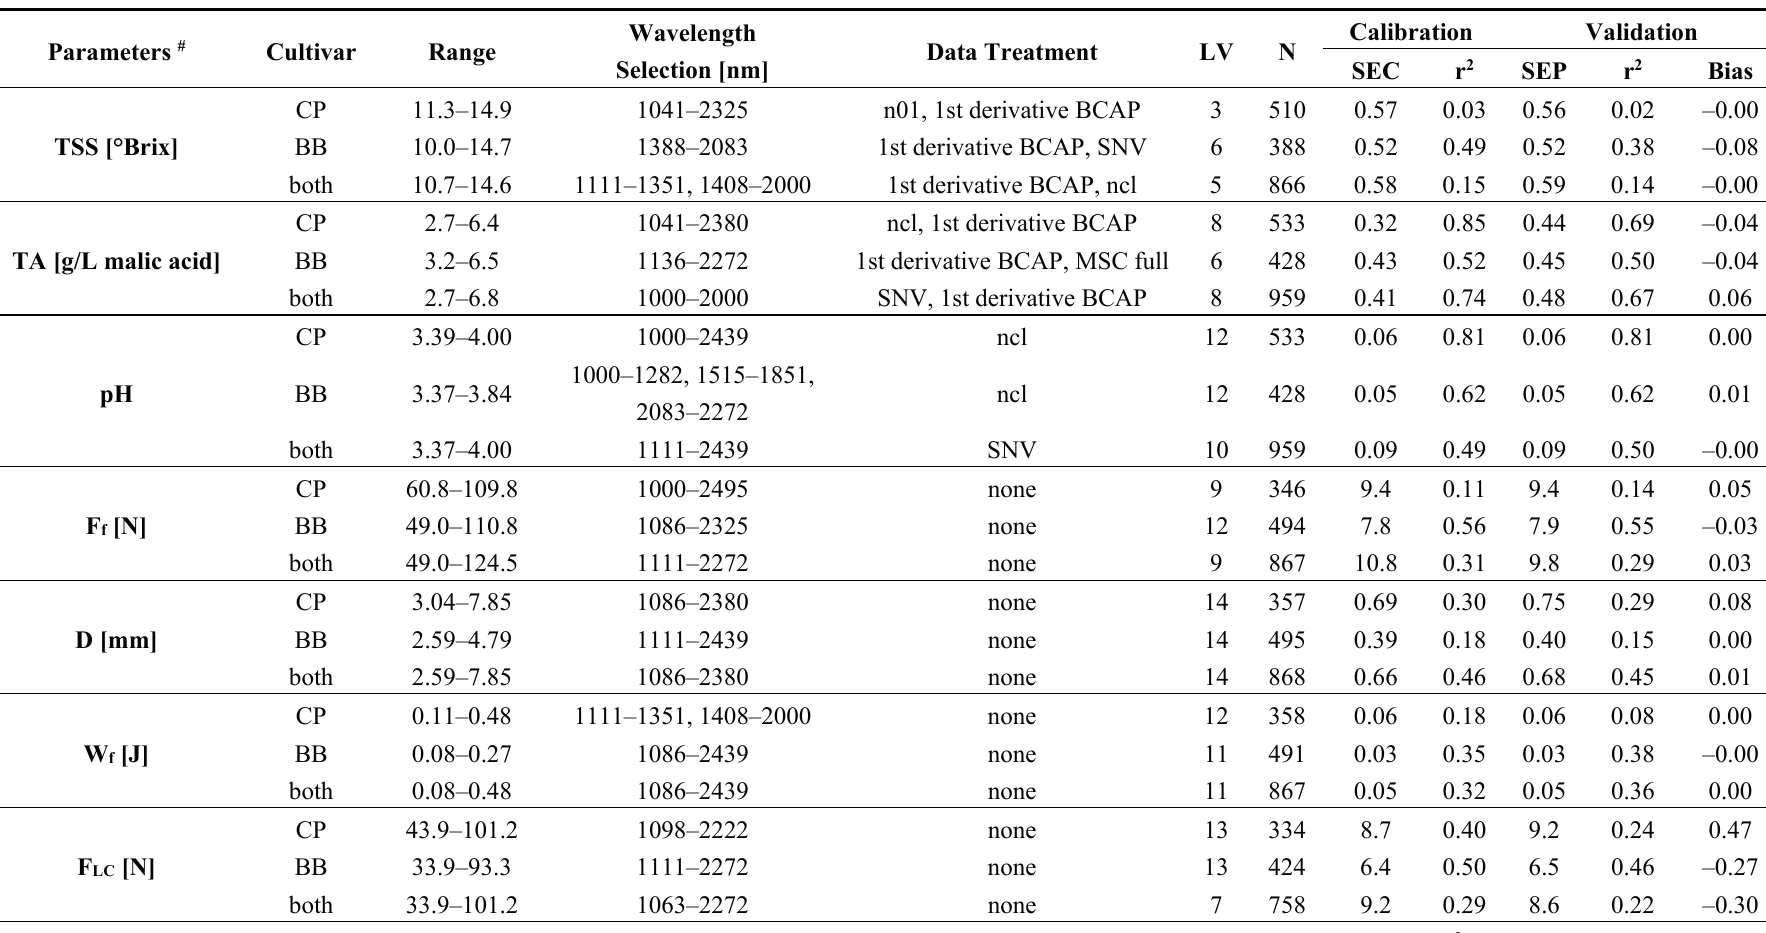
Table 3. Summary of the best NIR prediction models for the indicated apple quality parameters: “Cripps Pink” (CP), “Braeburn” (BB), the latent variables (LV), the standard error of calibration (SEC), the standard error of prediction (SEP), root mean square error of cross validation (RMSECV), the coefficient of determination (r 2 ) referring to validation and calibration, and the bias referring to prediction. The overall range of the wet chemical values, wavelength selections, the data pre-treatments, and the amount of total samples (N) are